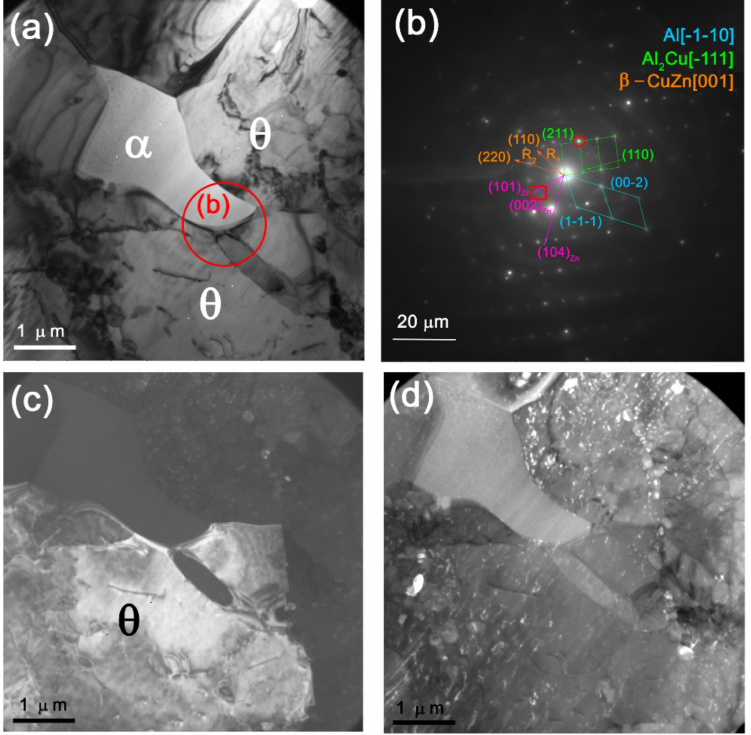
Figure 8. Bright-field image with selected area diaphragm ( a ), SAED pattern ( b ), dark-field image ( c ) obtained using reflections (321) θ , and dark-field image ( d ) obtained using reflections (110) CuZn and (002) Zn